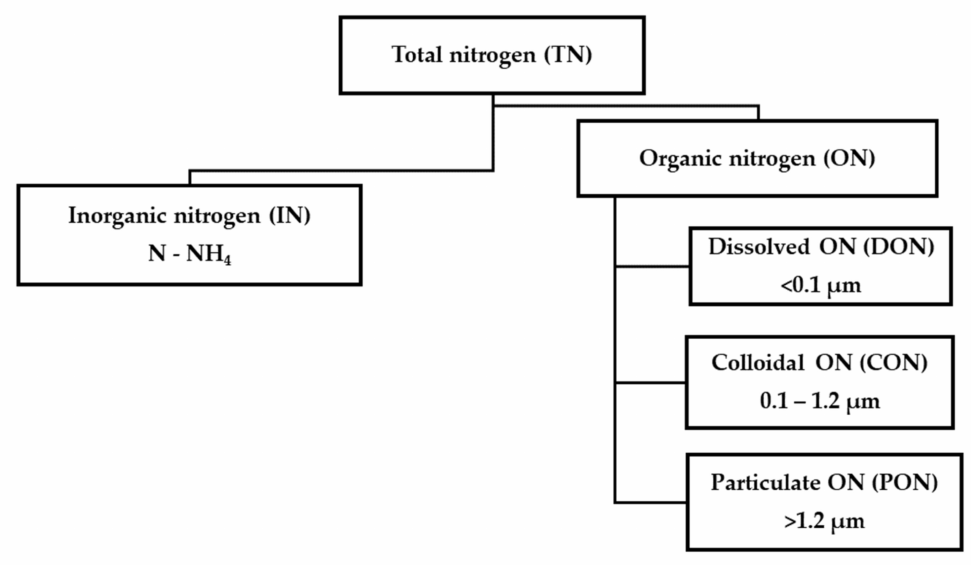
Figure 2. Scheme of nitrogen fractionation for the liquid fraction of the